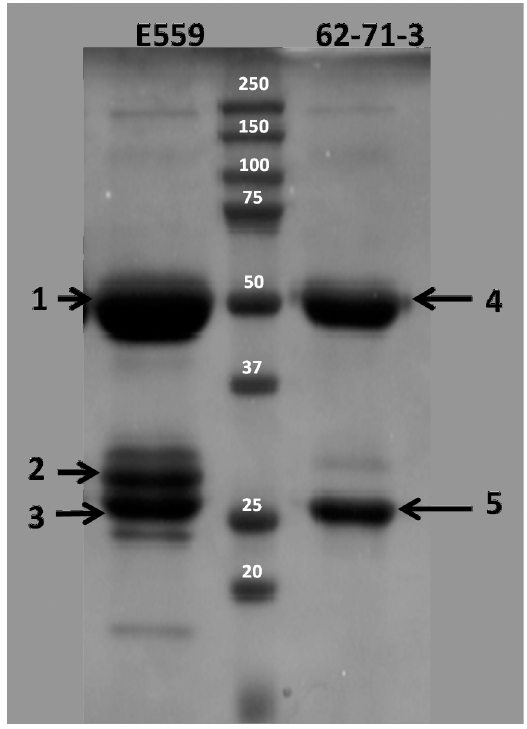
Fig 1. SDS-PAGE analysis of purified E559 and 62-71-3 mAbs. The middle lane was a PageRuler Prestained Protein Ladder, with the sizes indicated in kDa. The numbered E559 and 62-71-3 bands (1 – 5) were used for further